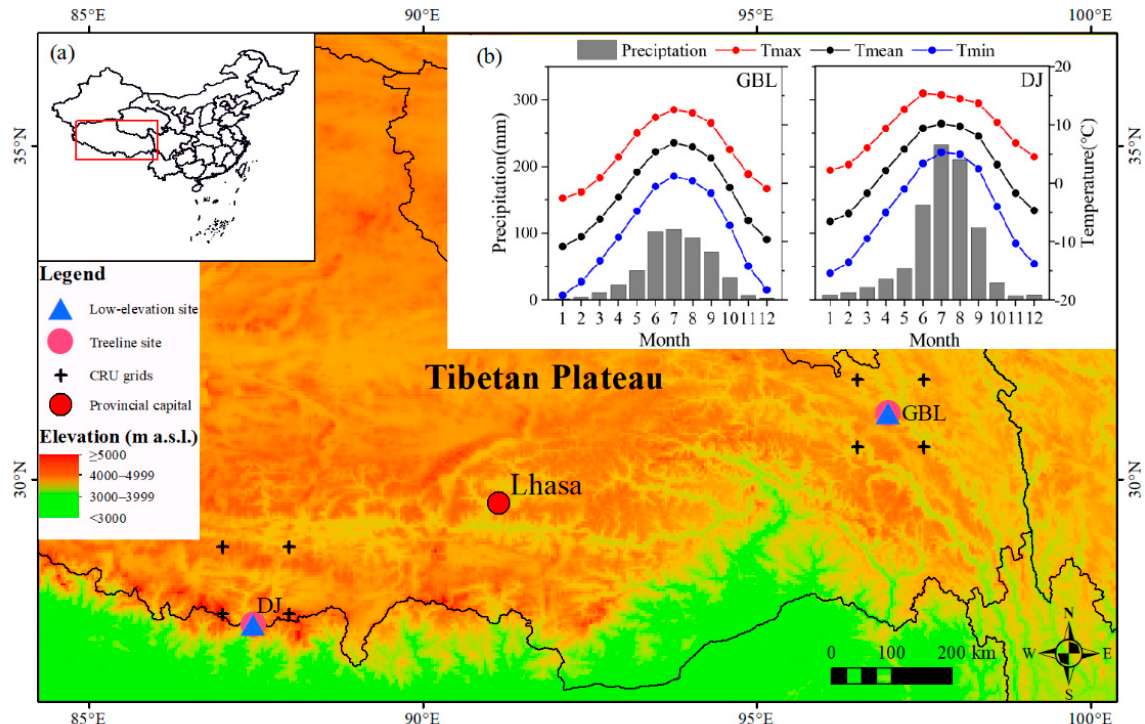
Figure 1. Location map of the two elevational transects on the Tibetan Plateau ( a ), and ( b ) the climate diagrams based on the climate records from the nearest CRU TS 4.04 grids for the period 1955–2014 (https://catalogue.ceda.ac.uk/uuid/89e1e34ec3554dc98594a5732622bce9, accessed on 10th June, 2020). The monthly temperatures include maximum temperature (Tmax), mean temperature (Tmean), minimum temperature (Tmin) and monthly